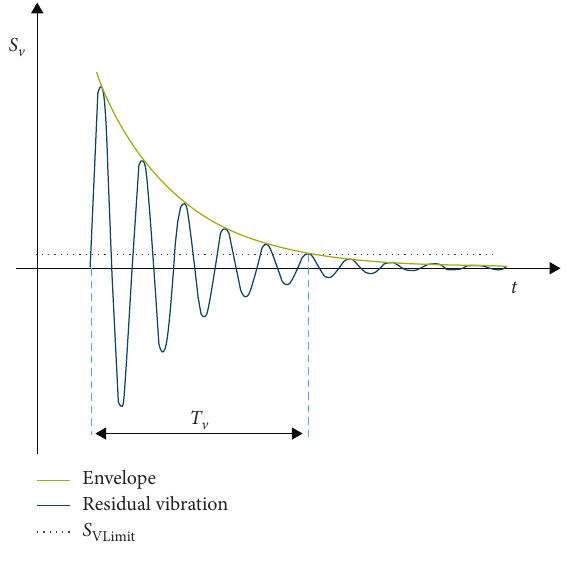
Figure 4: Residual vibration